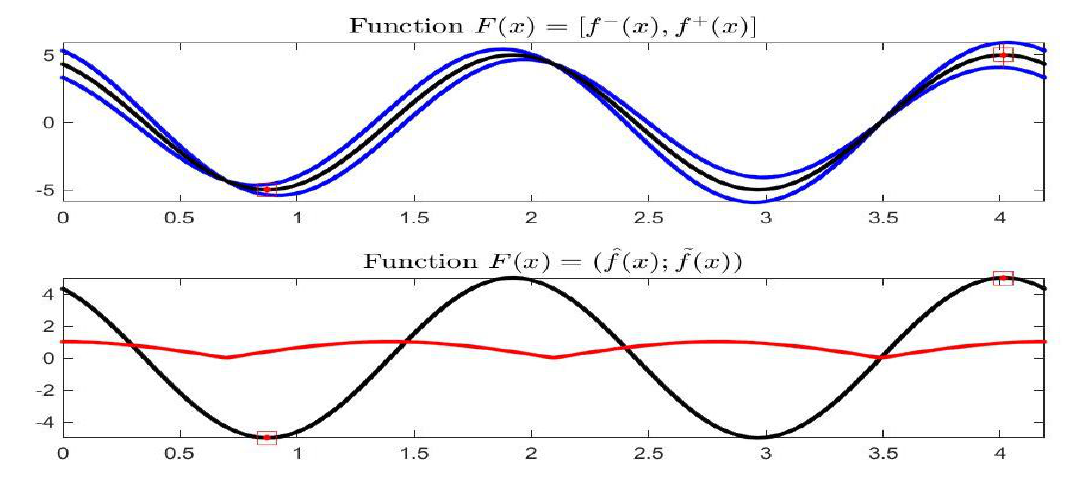
Figure 19. Periodic Example 1: Function F ( x ) is pictured on top and functions (cid:98) f ( x ) , (cid:101) f ( x ) on bottom. Marked points correspond to x m and x M , where the two functions are